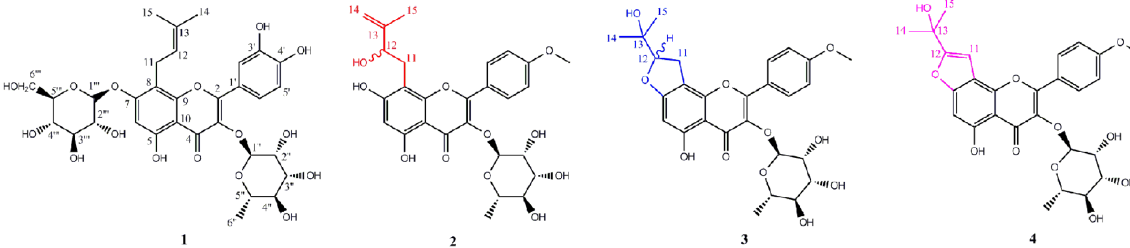
Figure 2. Chemical structures of new compounds 1–4 .